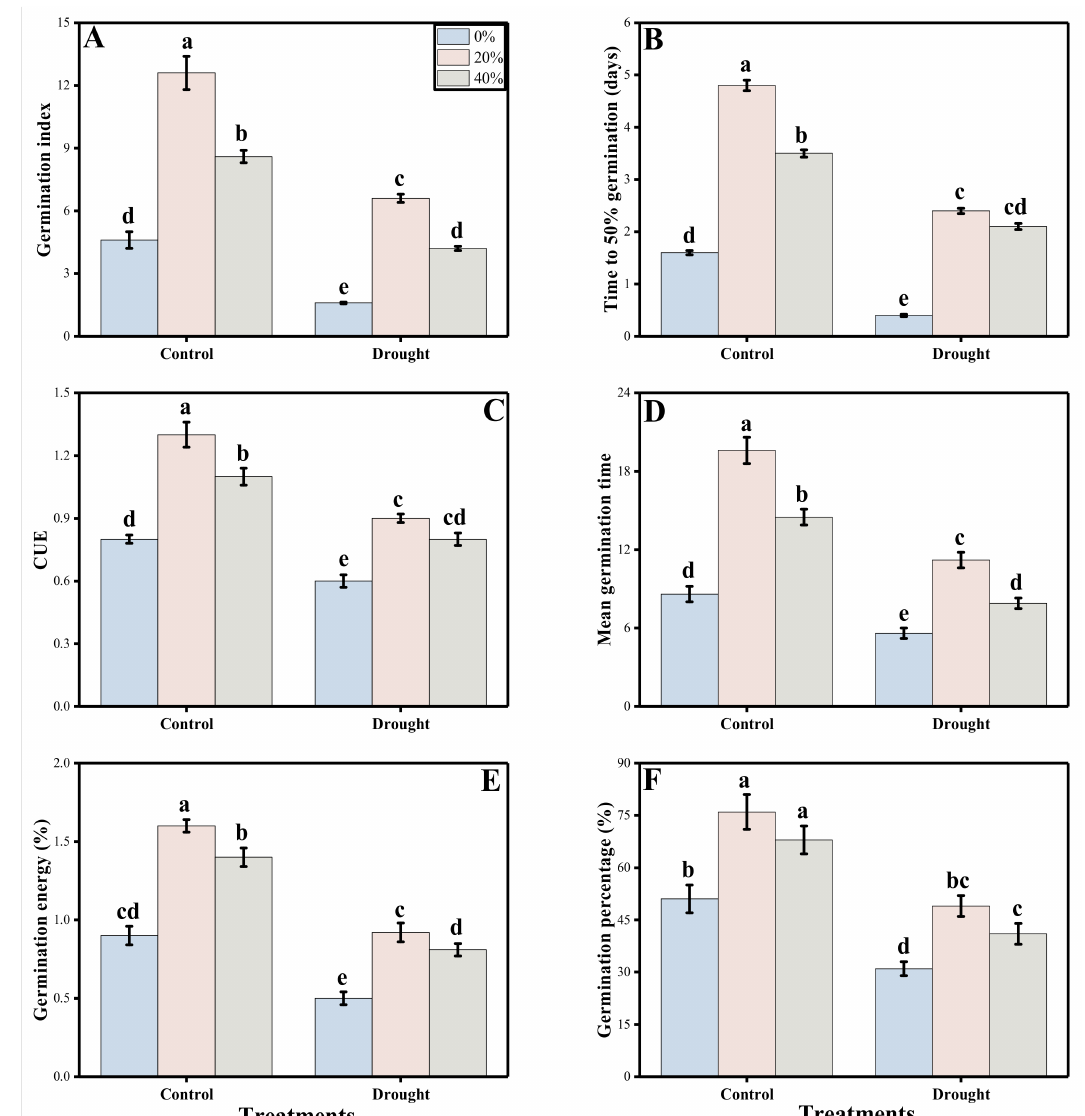
Figure 1. Effect of seed priming with Plantago ovata leaf extract on germination index ( A ), time to total 50% germination ( B ), coefficient of uniformity of emergence ( C ), mean germination time ( D ), germination energy ( E ) and germination percentage ( F ) under water stressed and non-stressed environments in maize cultivar Cimmyt-Pak. Means sharing similar letter(s) within a column for each parameter do not differ significantly at p < 0.05. Data in the figures are means of three repeats ( n = 3) of just one harvest of Zea mays plants ± standard deviation (SD). Different lowercase letters on the error bars indicate significant differences between the treatments. Different treatments ( P. ovata extract) used in this study are as